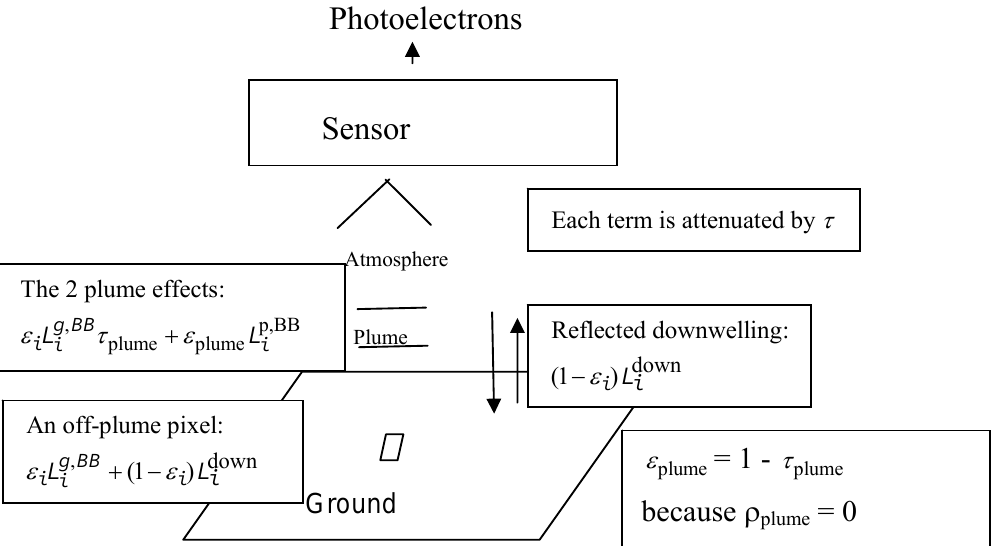
Figure 2 . Simple description of on-plume and off-plume pixels. Off-plume pixels contribute where